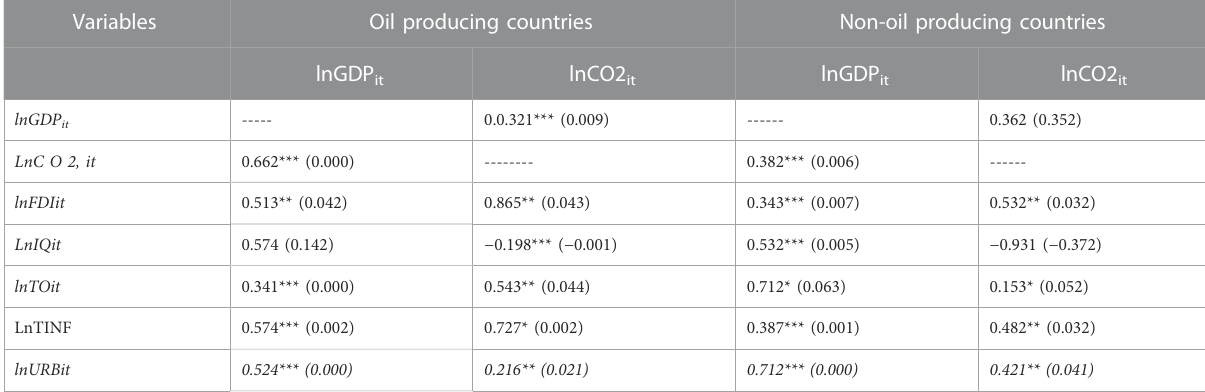
TABLE 7 Country-speci fi c analysis results estimated by the AMG